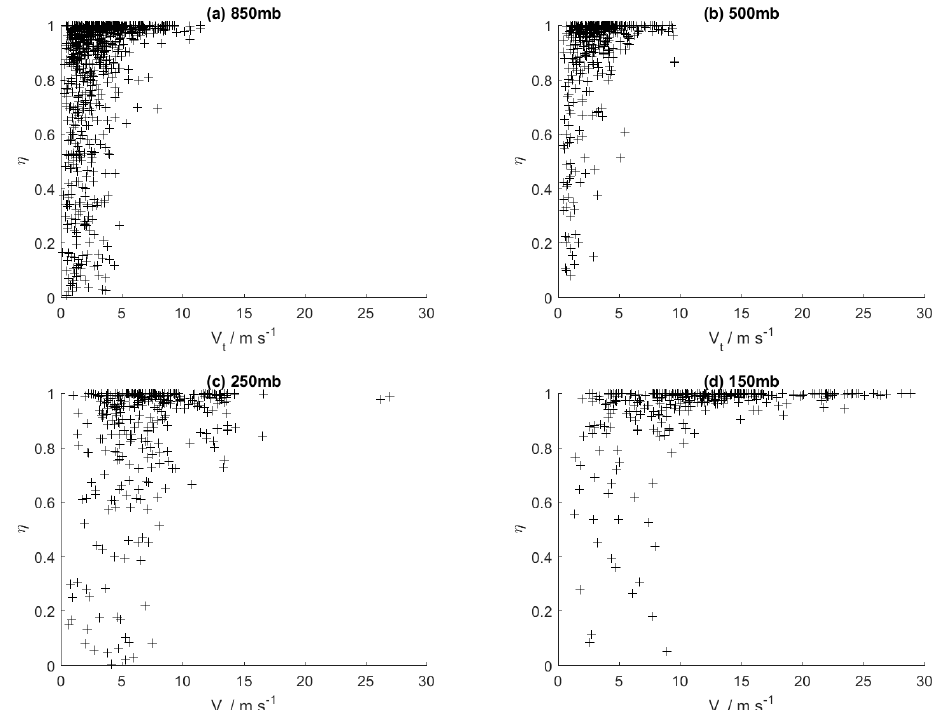
( c ) 250 mb; ( d ) 150 mb.